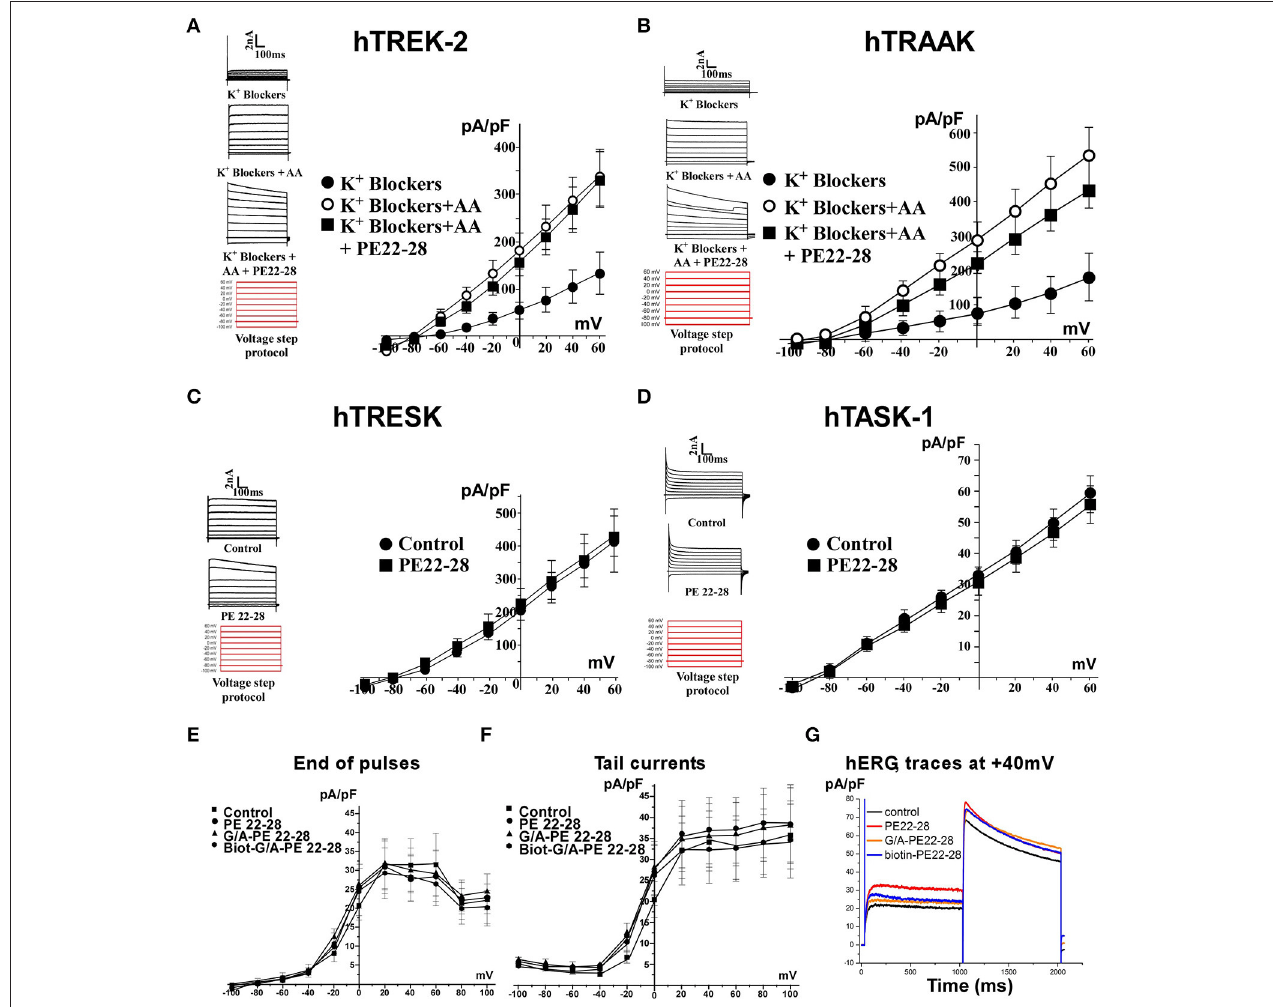
FIGURE 4 | Spadin-analog specificity. (A–D) PE 22-28 was used as the representative peptide for testing the specificity of spadin-analogs vs. other K 2P channels, TREK-2 (A) , TRAAK (B) , TRESK (C) , and TASK-1 (D) . (E–G) Spadin-analogs were without effect on hERG channel activity. Current densities at the end of pulses (E) , current densities of tail currents (F) , and typical traces obtained at + 40 mV with spadin-analogs (G)